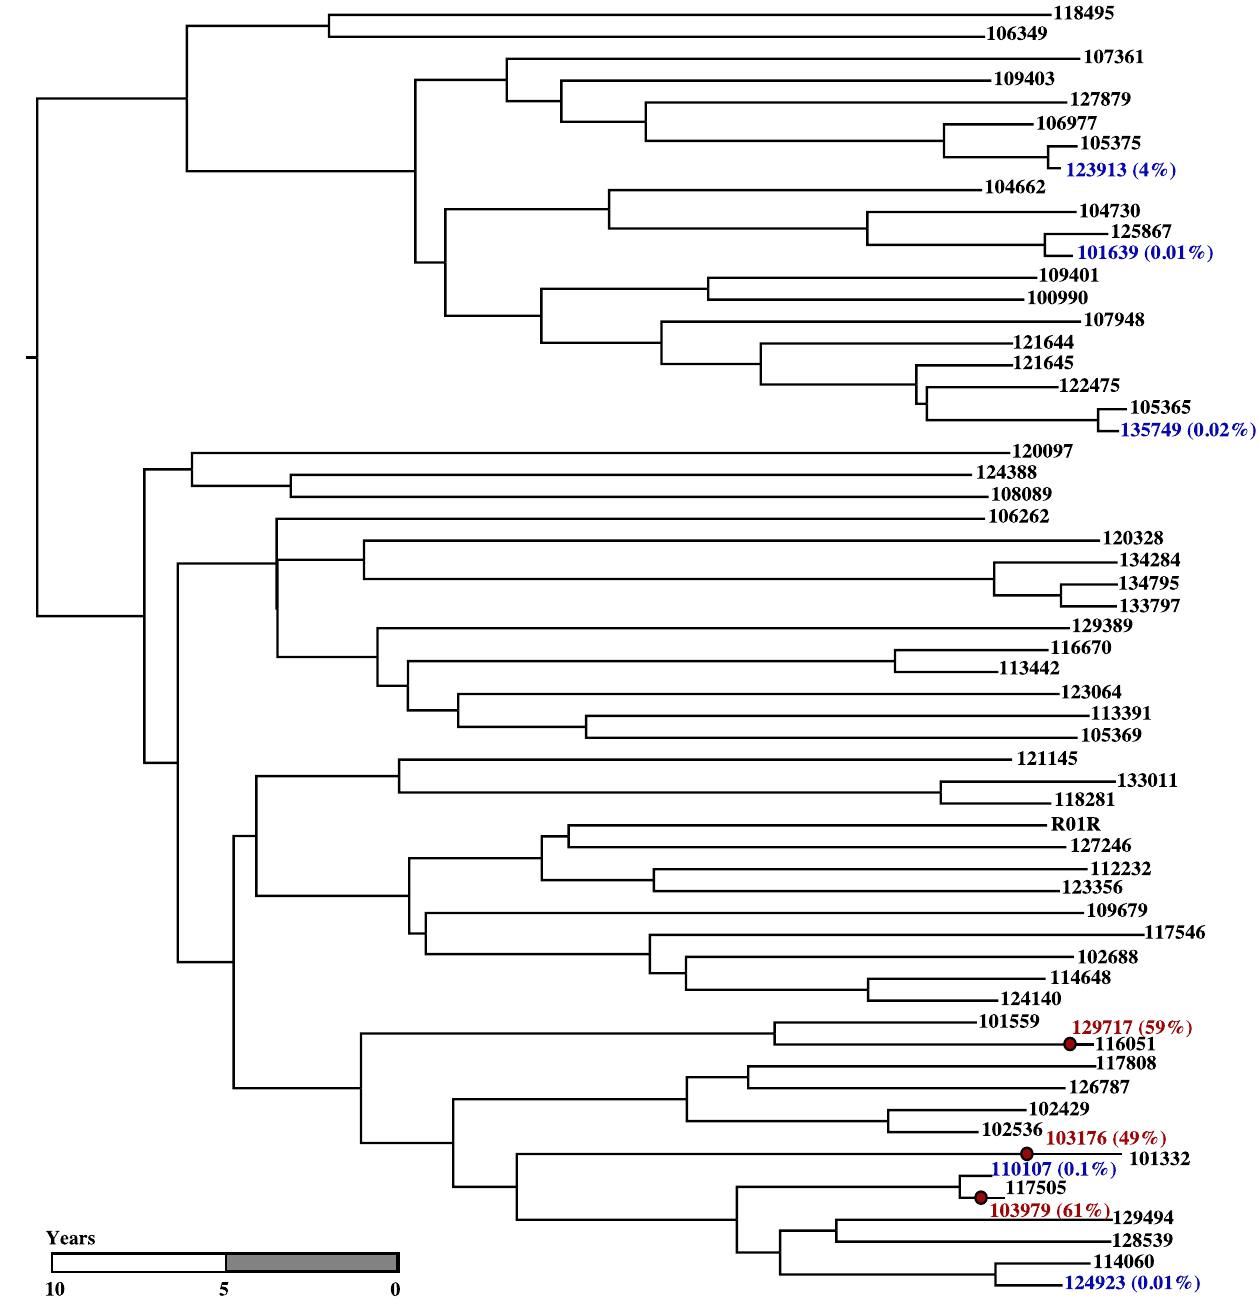
Figure 8. A tree sampled from the posterior of the HIV 1 dataset analysis. The tree exhibits three estimated sampled ancestors shown as red circles. The samples with positive posterior probabilities of being sampled ancestors are shown in colour (red for the nodes with evidence of being sampled ancestors and blue for other nodes with non-zero probabilities) with the posterior probabilities in round brackets.